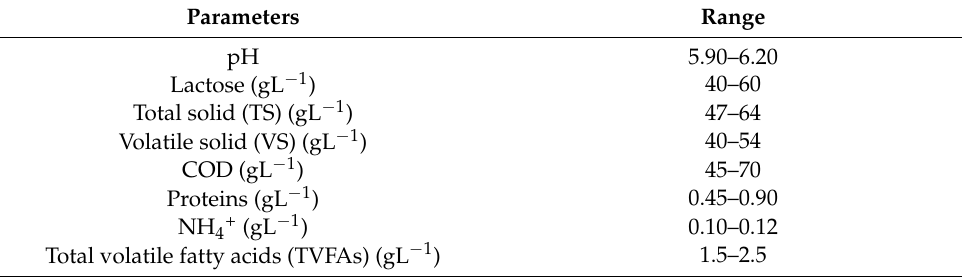
Table 1. Main characteristics of second cheese whey (SCW) used in this